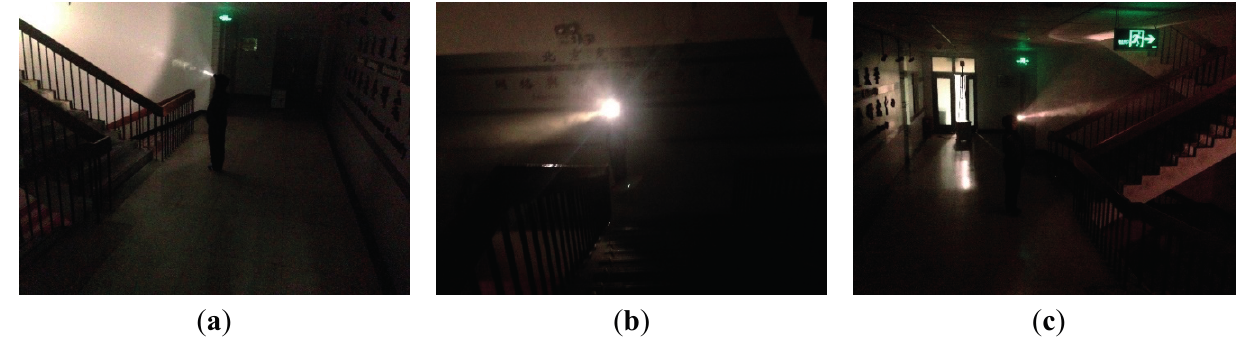
Figure 4. ( a ) The image of the corridor taken by camera C 1 ; ( b ) The image of the corridor taken by camera C 2 ; ( c ) The image of the corridor taken by camera C 3 .